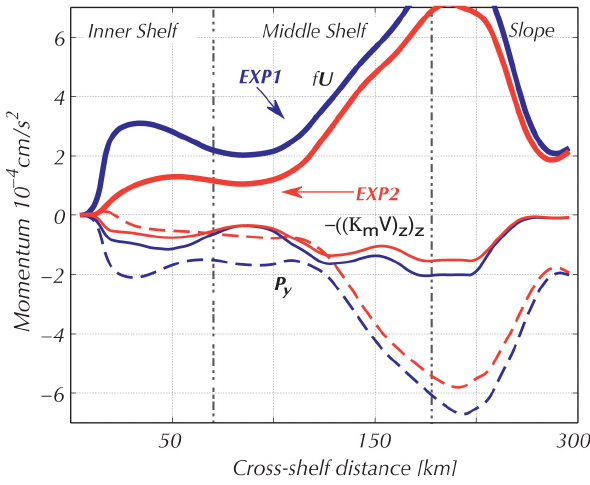
Fig. 5. Alongshelf component of the momentum balance across section C during summer.